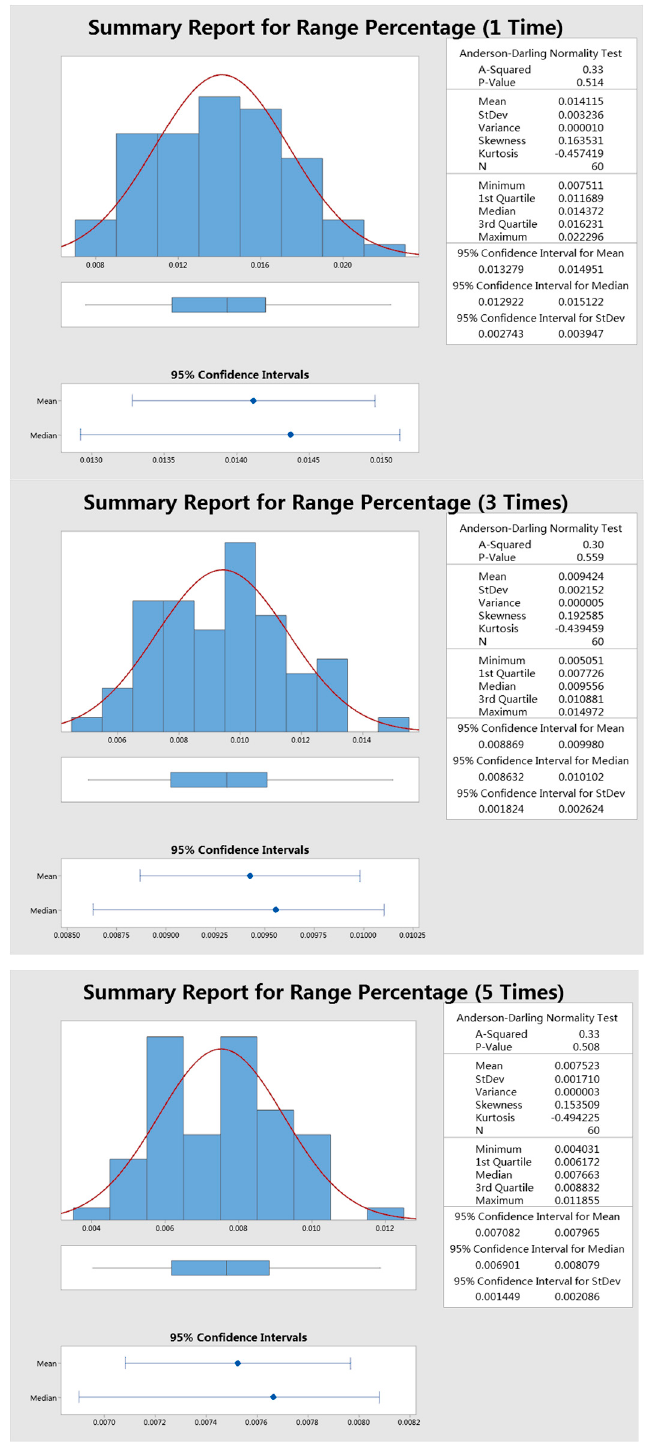
Figure A1. Percentage range distributions.